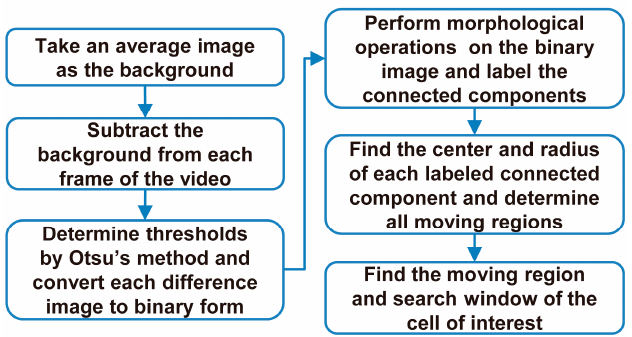
Figure 3. Automated tracking of the cell of interest in the video.